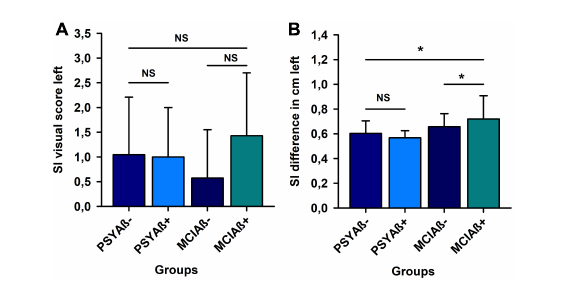
FIGURE2 β -amyloid pathology and substantia innominata atrophy. Four different groups regarding their β -amyloid status were compared [PSY with A β 42/40 ratio < 0.5 (PSYA β +, n = 3) and PSY with A β 42/40 ratio > 0.5 (PSYA β -, n = 21), MCI with Aß42/40 ratio < 0.5 (MCIA β +, n = 7) and MCI with A β 42/40 ratio > 0.5 (MCIA β -, n = 21)]. The visual score on the left (A) SI did not differ between groups. However, the left SI difference (in mm) was significantly less in the PSYA β - than the MCIA β + group (B) . SI, substantia innominata. *Means p < 0.05, NS means non.-significant. Aß42/40 ratio, ratio of amyloid-ß42/amyloid-ß40; PSY, psychiatric-onset; MCI, psychiatric onset.